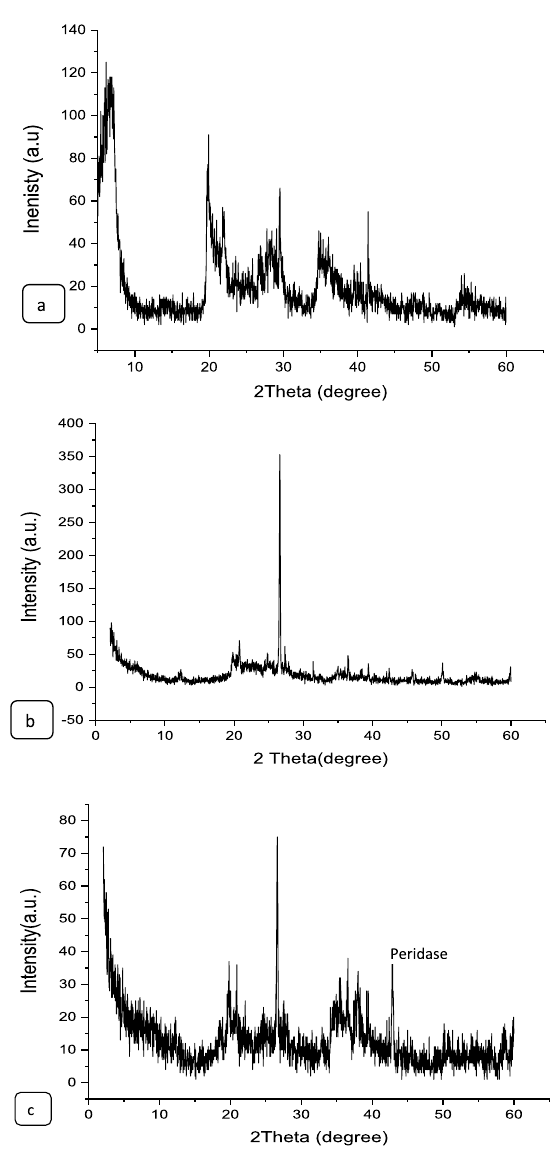
Fig. 3 X-ray diffraction patterns of a raw bentonite, b nano-bentonite and c MgO impregnated